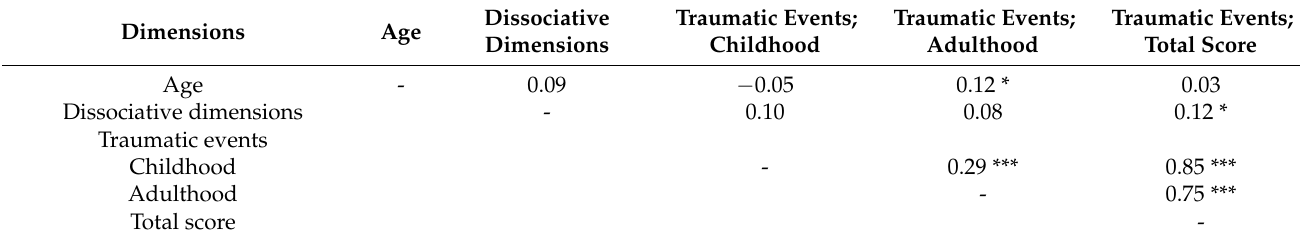
Table 2. Correlation coefficients between age, dimensions of dissociation, and traumatic experiences (always continuous